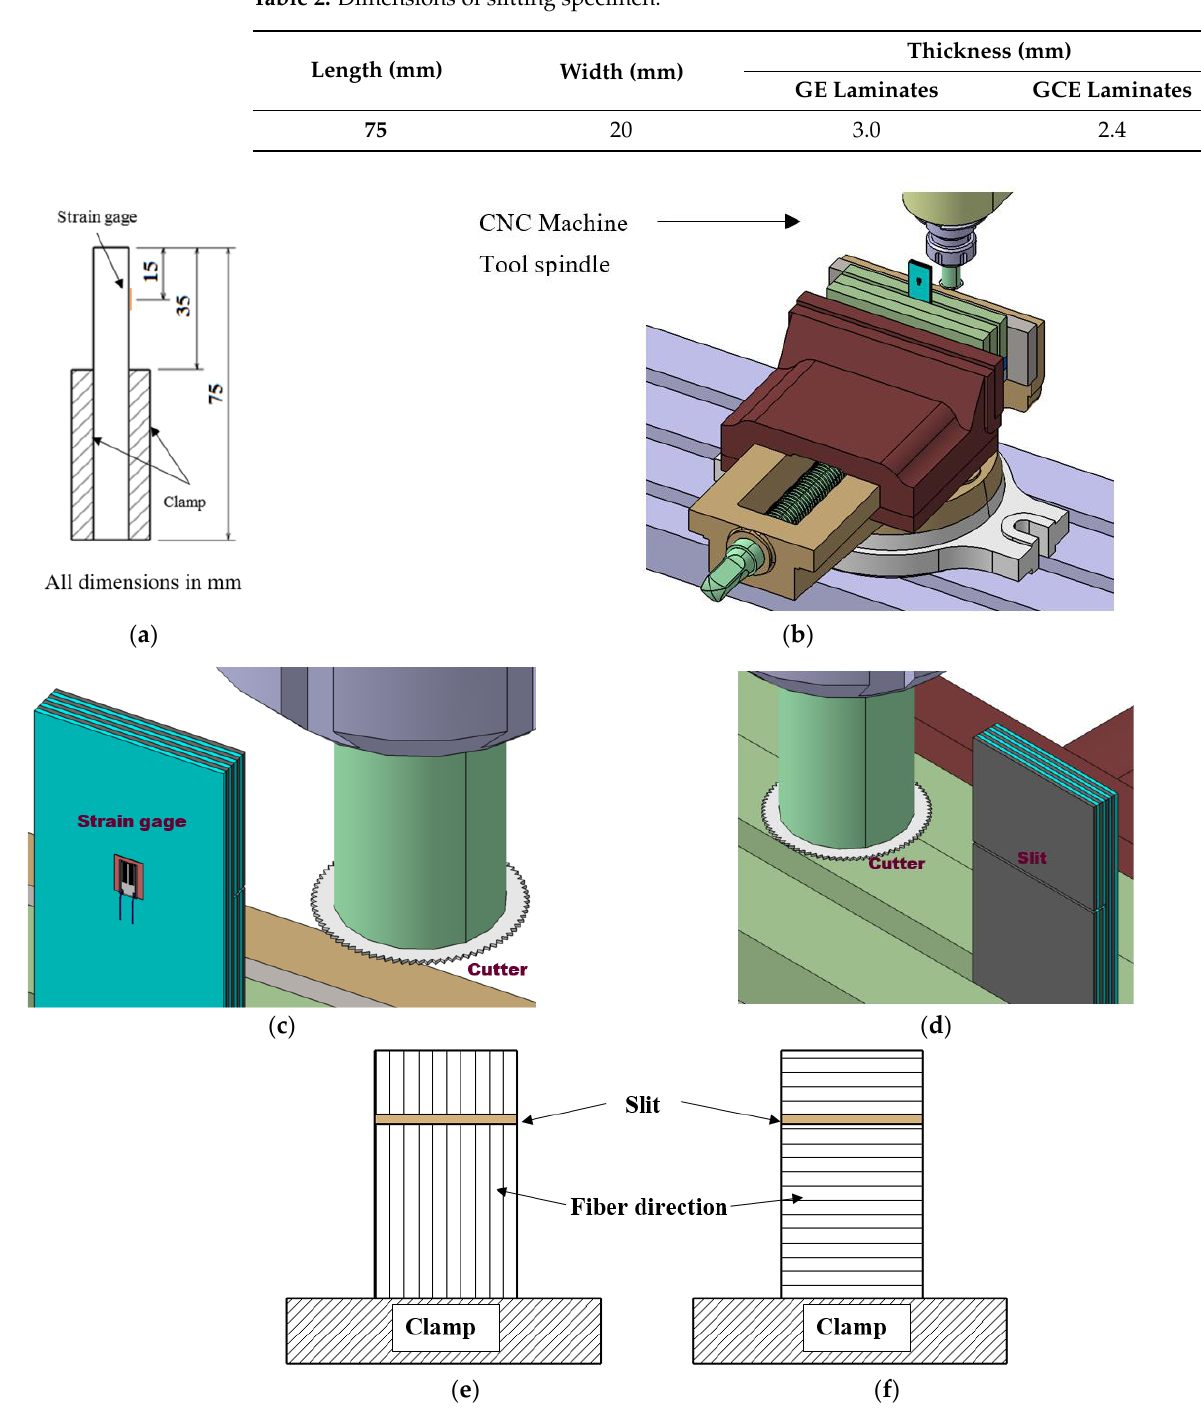
Figure 3. Schematic illustrations of ( a ) Slitting specimen with a bonded strain gage. ( b ) Experimental setup for the slitting experiment. ( c ) Relative position of strain gage and cutter ( d ) Relative position of cutter and slit. ( e ) Slitting specimen used for determination of longitudinal residual stress. ( f ) Slitting specimen used for determination of transverse residual stress.